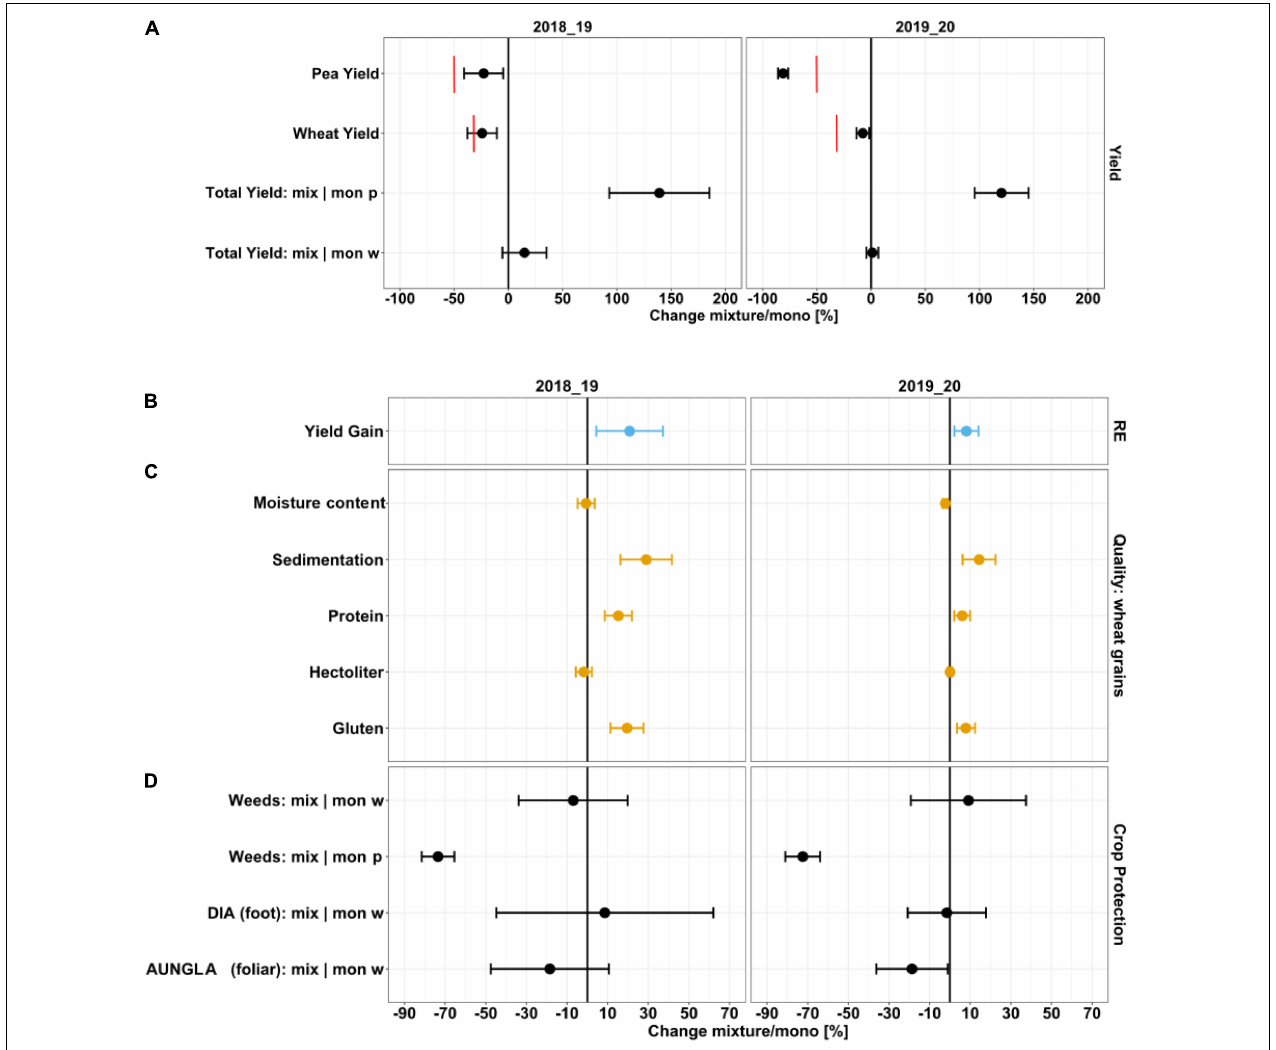
FIGURE 2 | Mixture effects on (A) yield, (B) yield gain as a measure of resource efficiency (RE), (C) quality parameters of wheat, and (D) crop protection. Red bars indicate expected yield levels of wheat and pea-based on sowing densities in mixtures compared to pure stands. Estimated marginal means and 0.95 confidence intervals were derived from nlmes. Total yield and weeds are referred to either relative to wheat monocultures (mix|mon w) or relative to pea monocultures (mix|mon